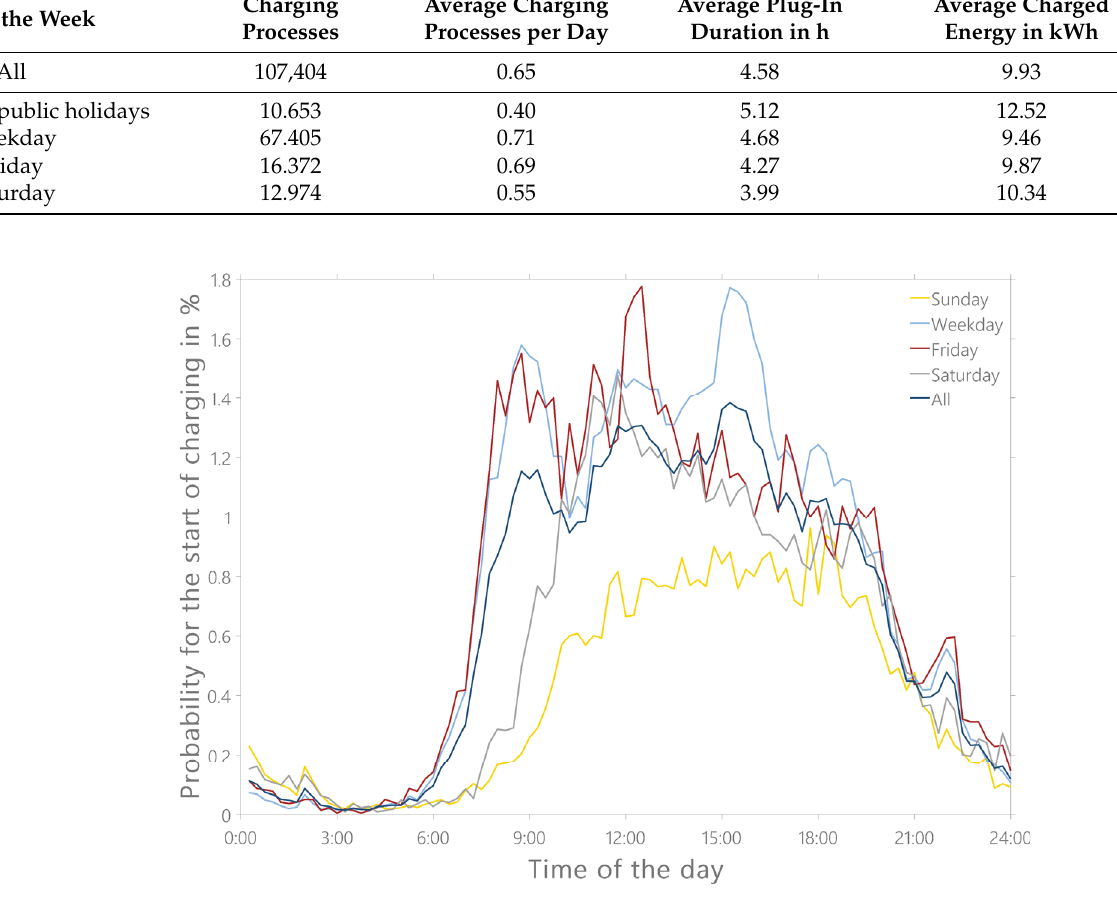
Figure A1. Probabilities for the start of a charging process classified by type-days in 15 min resolution including the calculation of public holidays as Sundays.